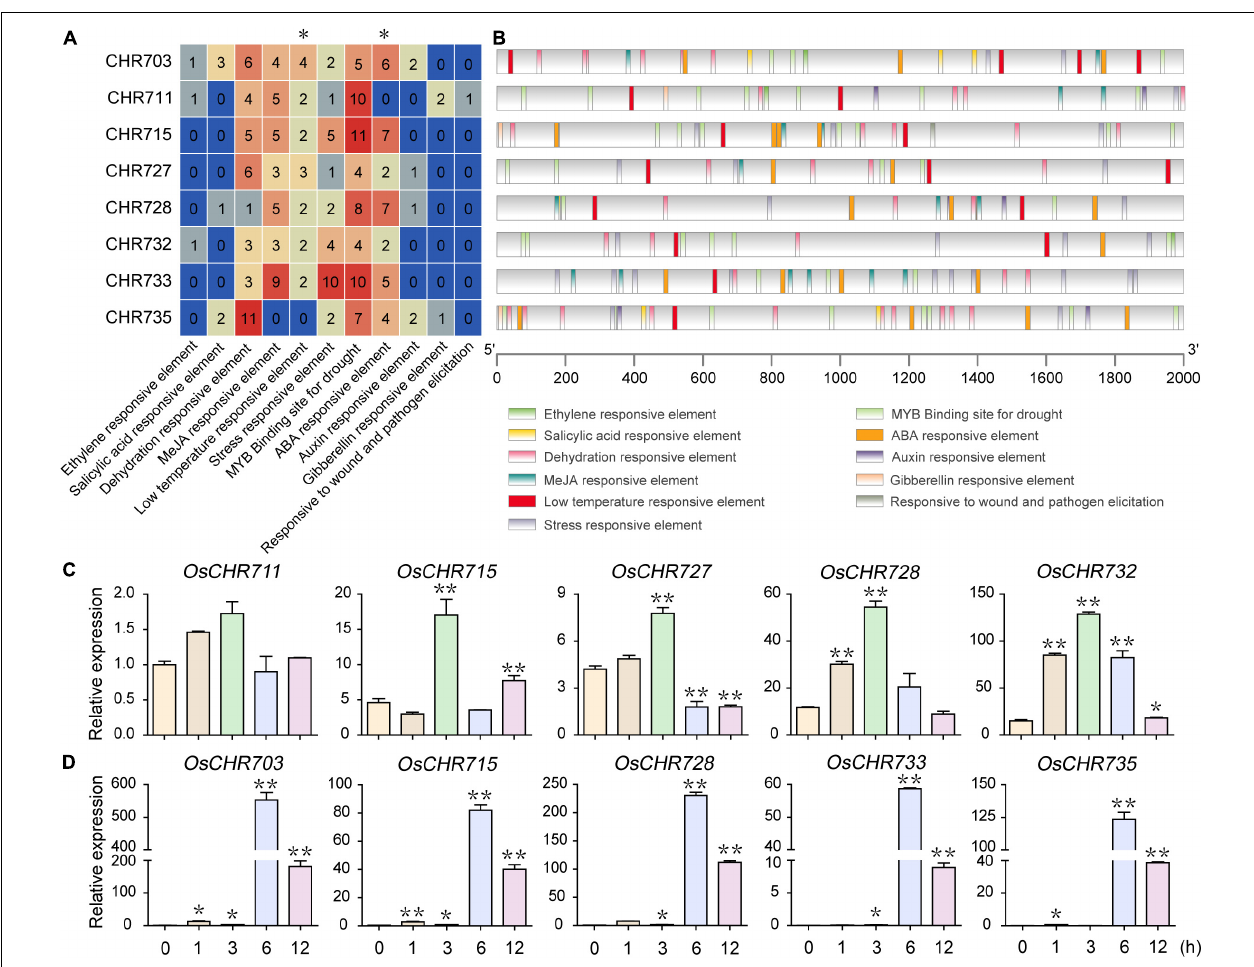
FIGURE 5 | Prediction of cis -acting elements of environmental stress-related and hormone-responsive in Snf2 genes. (A) Number of cis -acting elements detected in the promoter regions (sequence retrieved from about ≤ 2 kb upstream region). The cis -acting elements were divided into 11 types. (B) Quantity, kind and position of environmental stress-related and hormone-responsive elements in the putative promoters of genes in Figure 5A . (C) The qRT-PCR analysis of Snf2 genes containing multiple LTR (low temperature-responsive) elements under 4 ◦ C treatment. (D) The qRT-PCR analysis of Snf2 genes containing multiple ABA-responsive elements under ABA treatment. The y -axis is the relative expression level of the gene compared to OsUBQ5 under different treatments using the qRT-PCR (C,D) . The relative expression level of OsCHR711 to OsUBQ5 in an unstressed sample (0 h) normalized as “1” was used as a reference. Error bars indicate standard deviations of independent biological replicates ( n = 3). Data are given as means ± SD. * p < 0.05, ** p < 0.01 compared with unstressed samples using Student’s t